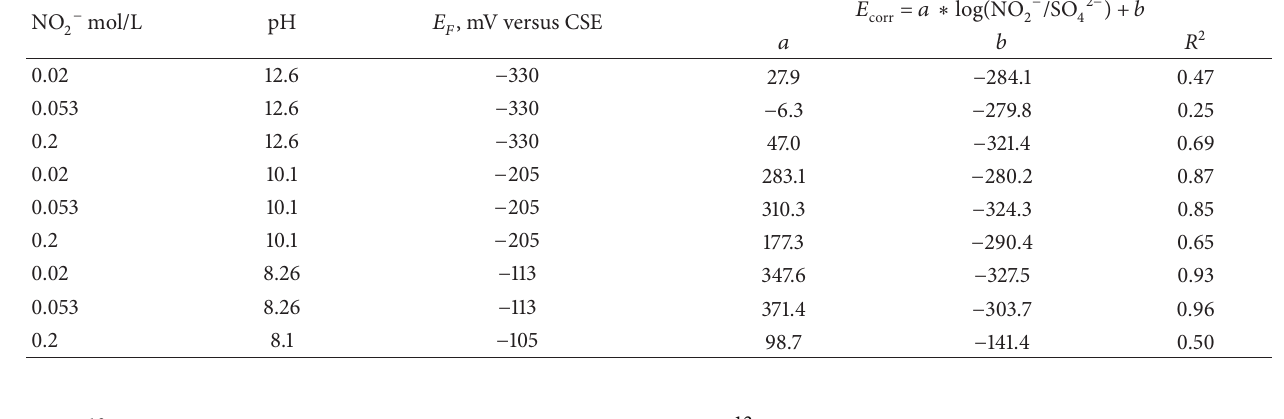
and log(NO 2− /SO 42− ). corr